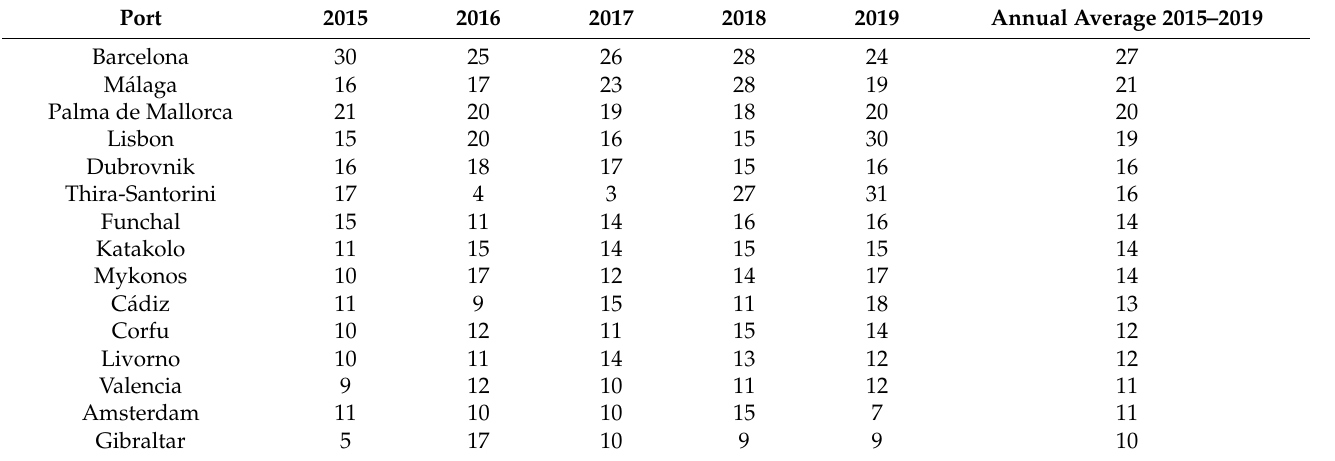
Table 7. Top 15 ports in terms of out-coming degree and its evolution from 2015 to 2019 in the contemporary cruise port network in Southern Europe.